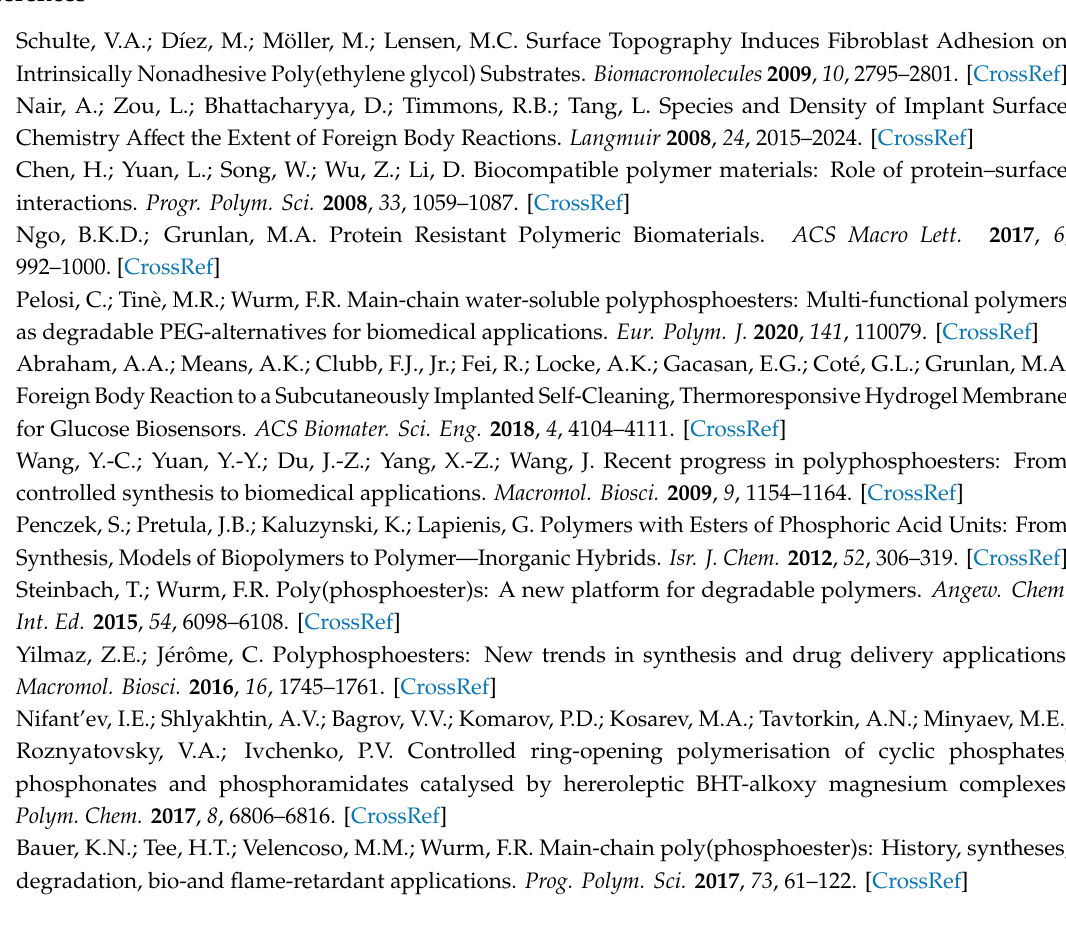
Figure S1 . 1 H NMR spectrum (400 MHz, CDCl 3 , 20 ◦ C) of ε CL homopolymer P1 ; Figure S2 . 1 H NMR spectrum (400 MHz, CDCl 3 , 20 ◦ C) of copolymer P2 ; Figure S3 . 1 H NMR spectrum (400 MHz, CDCl 3 , 20 ◦ C) of copolymer P3 ; Figure S4 . 1 H NMR spectrum (400 MHz, CDCl 3 , 20 ◦ C) of copolymer P4 ; Figure S5. Connective tissue capsules after 28 days after subcutaneous administration of the polymer films. Stained by hematoxylin and eosin, line segment 100 µ m; Figure S6 . CD68 + cells at the border between fibrous capsule and film. Immunocytochemical stain, fluorescent microscopy, cell nuclei stained by DAPI, line segment 50 µ